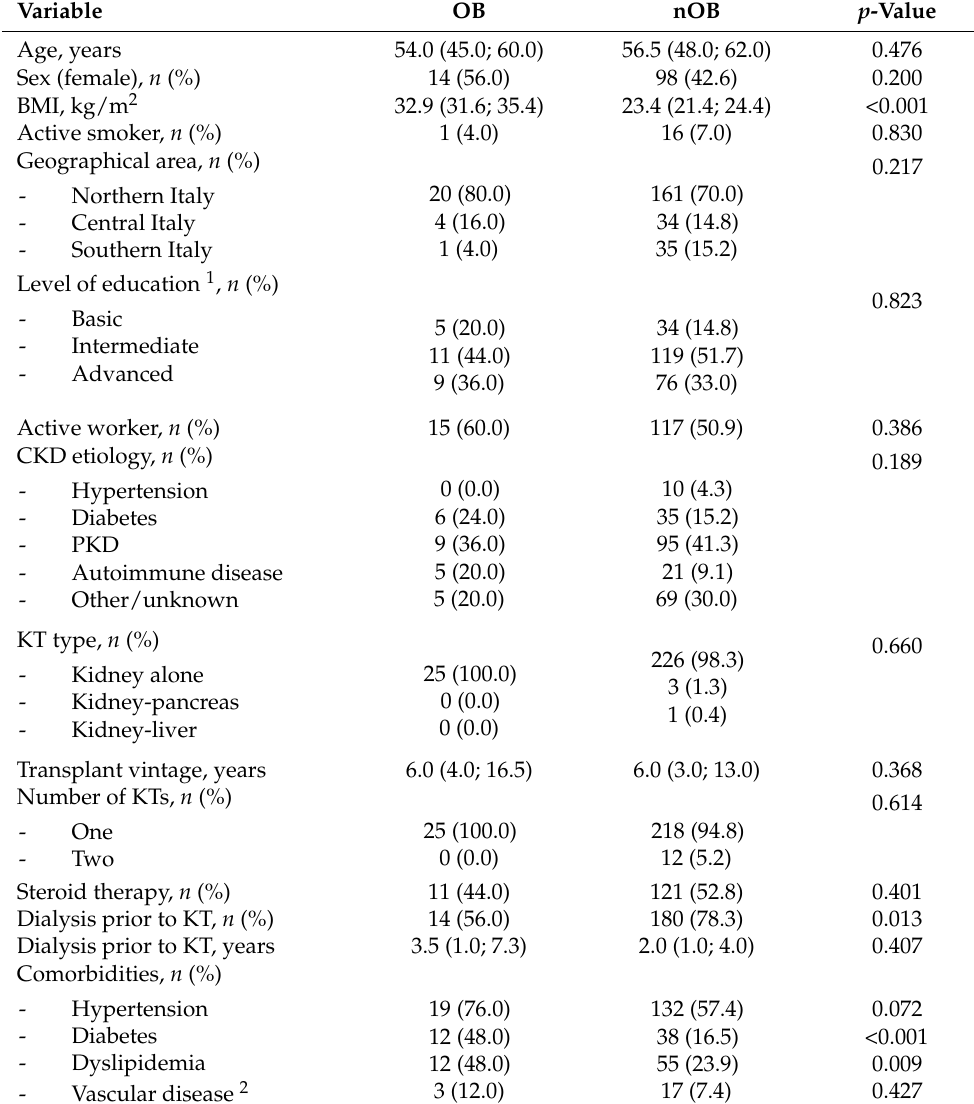
Table 2. Comparison between patients with (OB) and without (nOB) obesity.